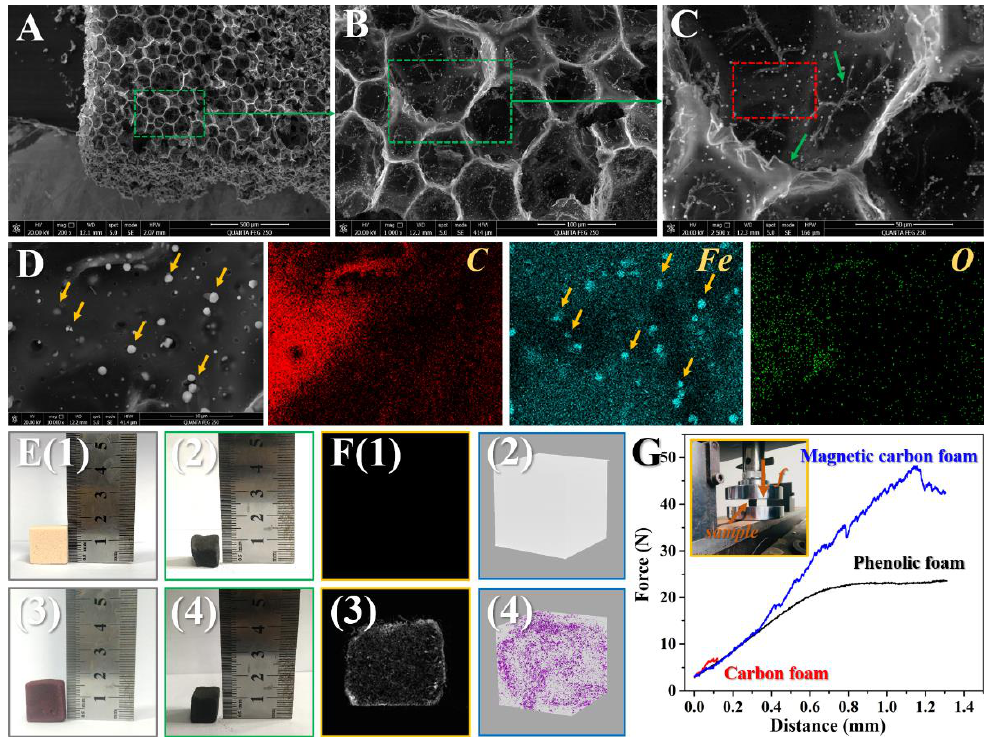
Figure 1. ( A–C ) The SEM micrographs of the magnetic carbon foam with different magnifications. ( D ) The corresponding EDS mapping images of the red-dashed squared area in Figure 1C. ( E ) Representative images of phenolic resin foam ( 1 ), carbon foam ( 2 ), phenolic resin foam containing Fe(acac) 3 ( 3 ), and magnetic carbon foam ( 4 ). ( F ) Cross-sectional and 3D reconstructional micro-CT imaging results of carbon foam (1 and 2) and magnetic carbon foam (3 and 4), respectively. ( G ) Compressive strength testing results of phenolic resin foam (black), carbon foam (red), and magnetic carbon foam (blue).